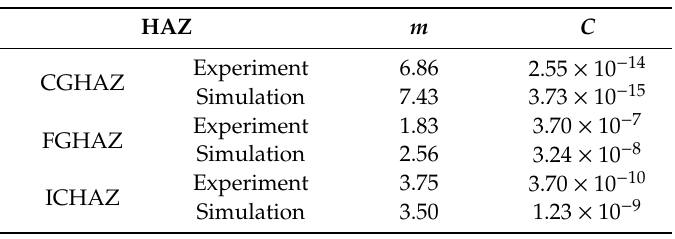
Table 3. The di ff erent fitting parameters of the da / dN - ∆ K curves between the welded joint specimen and thermal simulation sample.